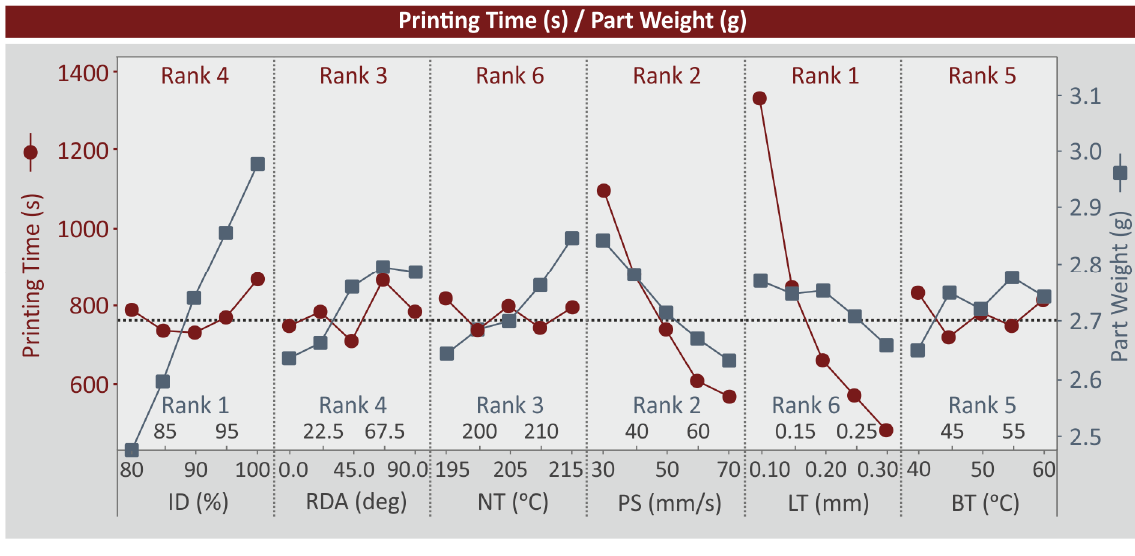
Figure 7. MEP: printing time (s), part weight (g).